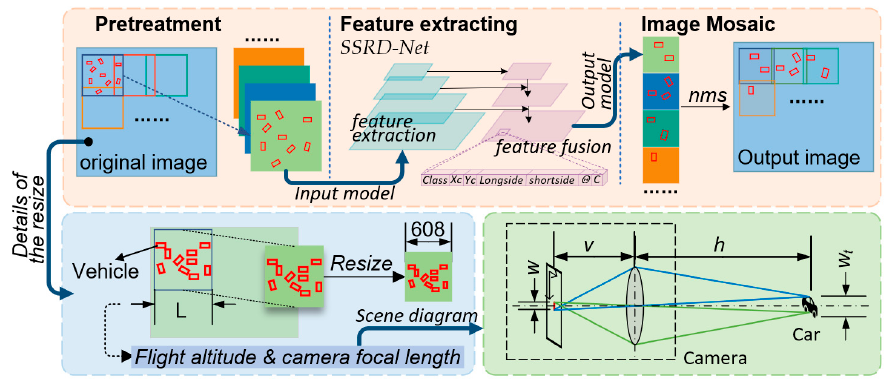
Figure 1. Proposed vehicle detection framework.